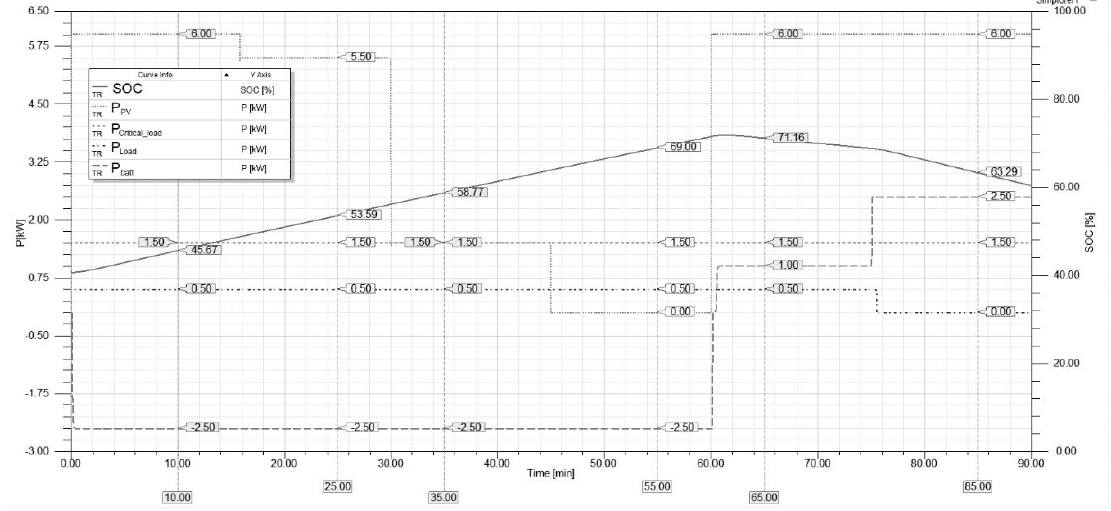
Figure 9. Power profile of NG1: SOC and power absorbed/supplied from the battery storage, power absorbed from the critical load (P critical_load ) and not critical (P load ), power production from PV plant (P PV ).